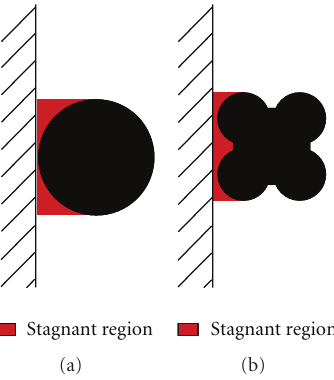
Figure 1: Stagnant regions formed near the polymer-metal inter- face for (a) round and (b) quad O-rings (cross-section shown).